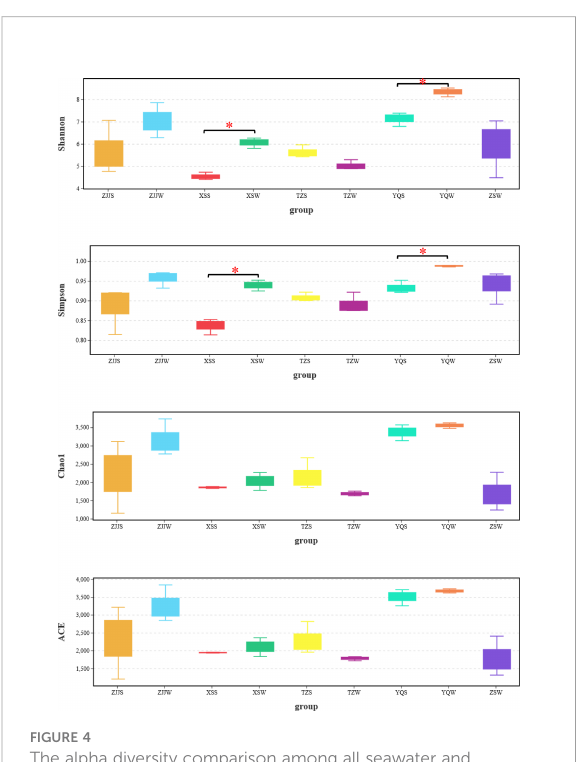
FIGURE 4 The alpha diversity comparison among all seawater and sediment groups via Shannon, Simpson, Chao1 and ACE indices. The “ * “ represents signi fi cant difference (P < 0.05) between the two